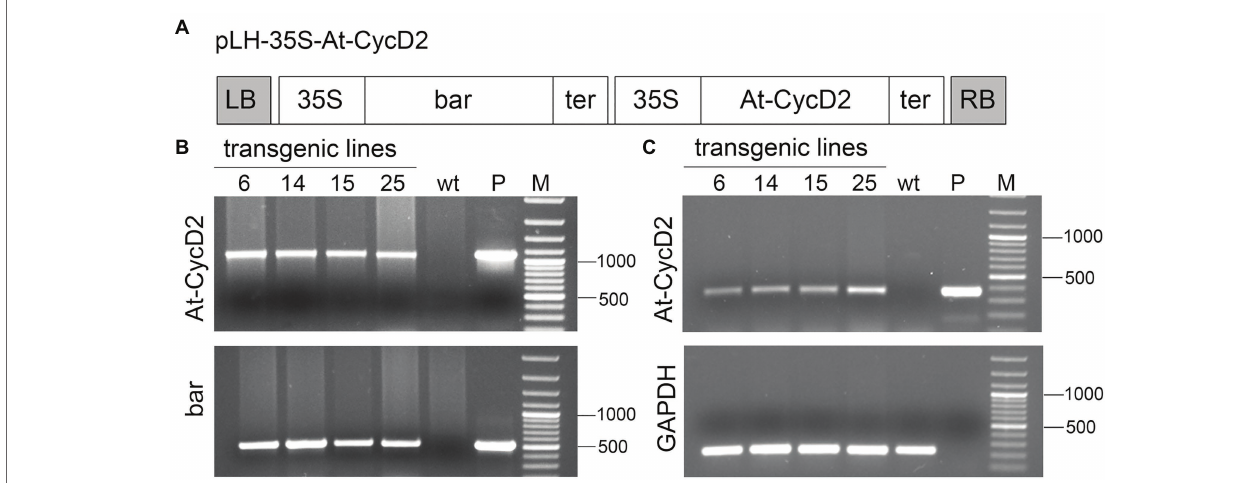
FIGURE 1 | Molecular characterization of the At-CycD2 transgenic lines. (A) Schematic representation of the pLH- 35S-At-CycD2 construct. The pLH- 35S-At- CycD2 plant transformation vector harbors bar and At-CycD2 expression cassettes. In both expression units the constitutive expression of the bar and At-CycD2 genes is regulated by the CaMV 35S promoter and terminator. Open boxes indicate the following genes: bar , At-CycD2 , bar and At-CycD2 genes, respectively; 35S, 35S promoter; ter, terminator. LB, RB, left and right border of T-DNA, respectively. (B) Verification of transgenic plants by PCR analysis. Genomic DNA from the PPT resistant regenerants (At-CycD2-6, At-CycD2-14, At-CycD2-15, and At-CycD2-25) was probed with primers specific to bar and At-CycD2 genes. DNAs of wild type N. benthamiana plant (wt) and plasmid pLH- 35S-At-CycD2 (P) were included as negative and positive controls, respectively. GeneRuler 100 bp Plus DNA marker (Thermo Scientific, Waltham, United States; M). (C) Expression analysis of the At-CycD2 gene in transgenic lines. RNA isolated form the PCR-positive primary transgenic plants (At-CycD2-6, At-CycD2-14, At-CycD2-15, and At-CycD2-25) was subjected to RT-PCR analysis using At-CycD2 and GAPDH specific primers. Non-transgenic N. benthamiana cDNA (wt) and plasmid pLH- 35S-At-CycD2 DNA (P) served as negative and positive controls, respectively. GeneRuler 100 bp Plus DNA marker (Thermo Scientific, Waltham, United States;